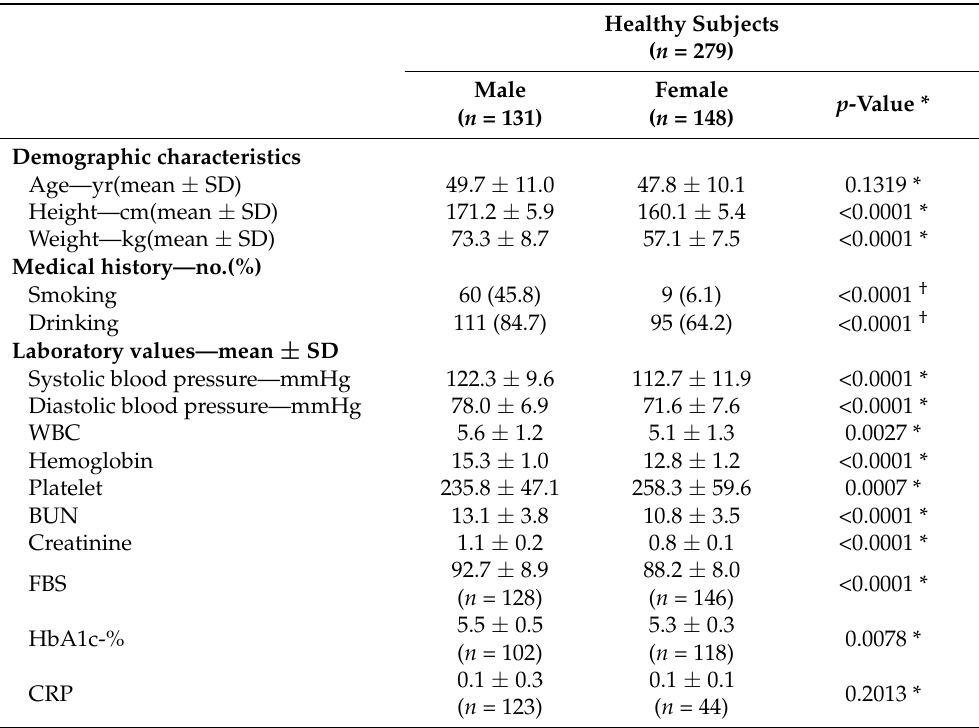
Table 1. Characteristics of 279 healthy